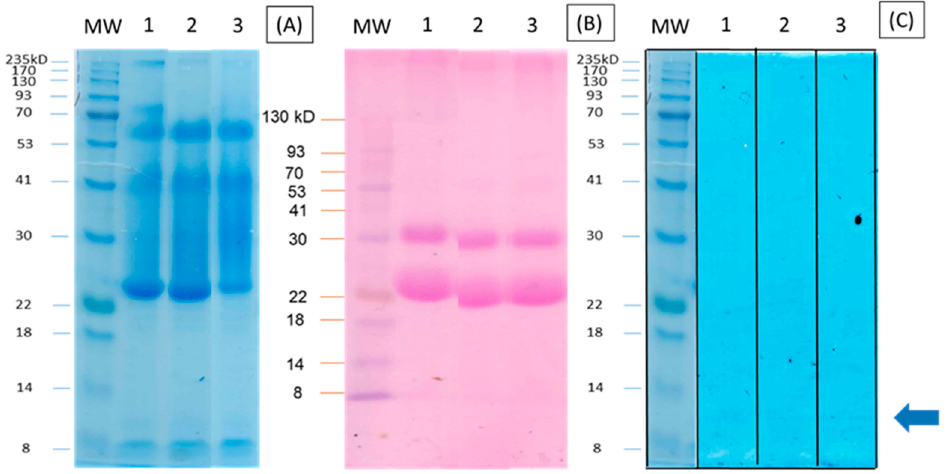
Figure 1. Physicochemical characterization of the LIP ‐ 70 extract from Tepary bean seeds. The layout of the lanes is as follows: (1) LIP-70 protein extract from treatment T1; (2) LIP-70 protein extract from treatment T2 and (3) LIP-70 protein extract from treatment T3. Foliar mechanical damage treatments: T1 (0%), T2 (50%) and T3 (80%). ( A ) The electrophoretic profiles of the fractions obtained by SDS ‐ PAGE, in 10% polyacrylamide gels by the Laemmli method, Coumassie stain. ( B ) Identification of glycoproteins present in the polyacrylamide gels following the Periodic-Acid Schiff staining technique (PASS). ( C ) Inhibition zymogram stained with Coumassie blue to observe the presence of trypsin inhibitors.